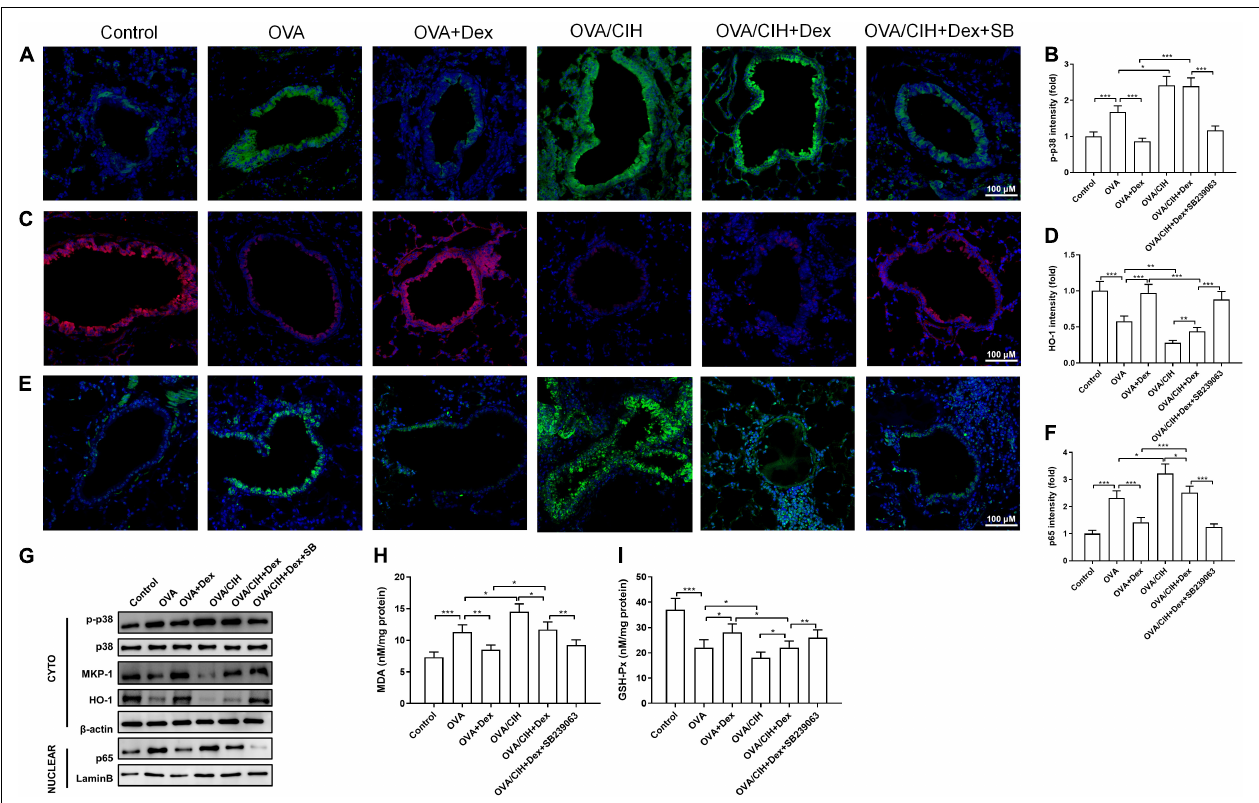
FIGURE 3 | The p38 MAPK pathway regulated allergic asthma in mice with CIH exposure. (A,B) Representative images of phosphor-p38 (green) and DAPI (blue) immunofluorescence-stained lung sections and phosphor-p38 intensity. (C,D) Representative images of HO-1 (red) and DAPI (blue) immunofluorescence-stained lung sections and HO-1 intensity. (E,F) Representative images of p65 (green) and DAPI (blue) immunofluorescence-stained lung sections and p65 intensity. (G) Levels of phosphor-p38, MKP-1, HO-1, and nuclear p65 in the lung were detected by western blot. (H) Lung MDA concentration. (I) Lung GSH-Px activity. Data are shown as the means ± SEM ( n = 6; * p < 0.05; ** p < 0.01; *** p <